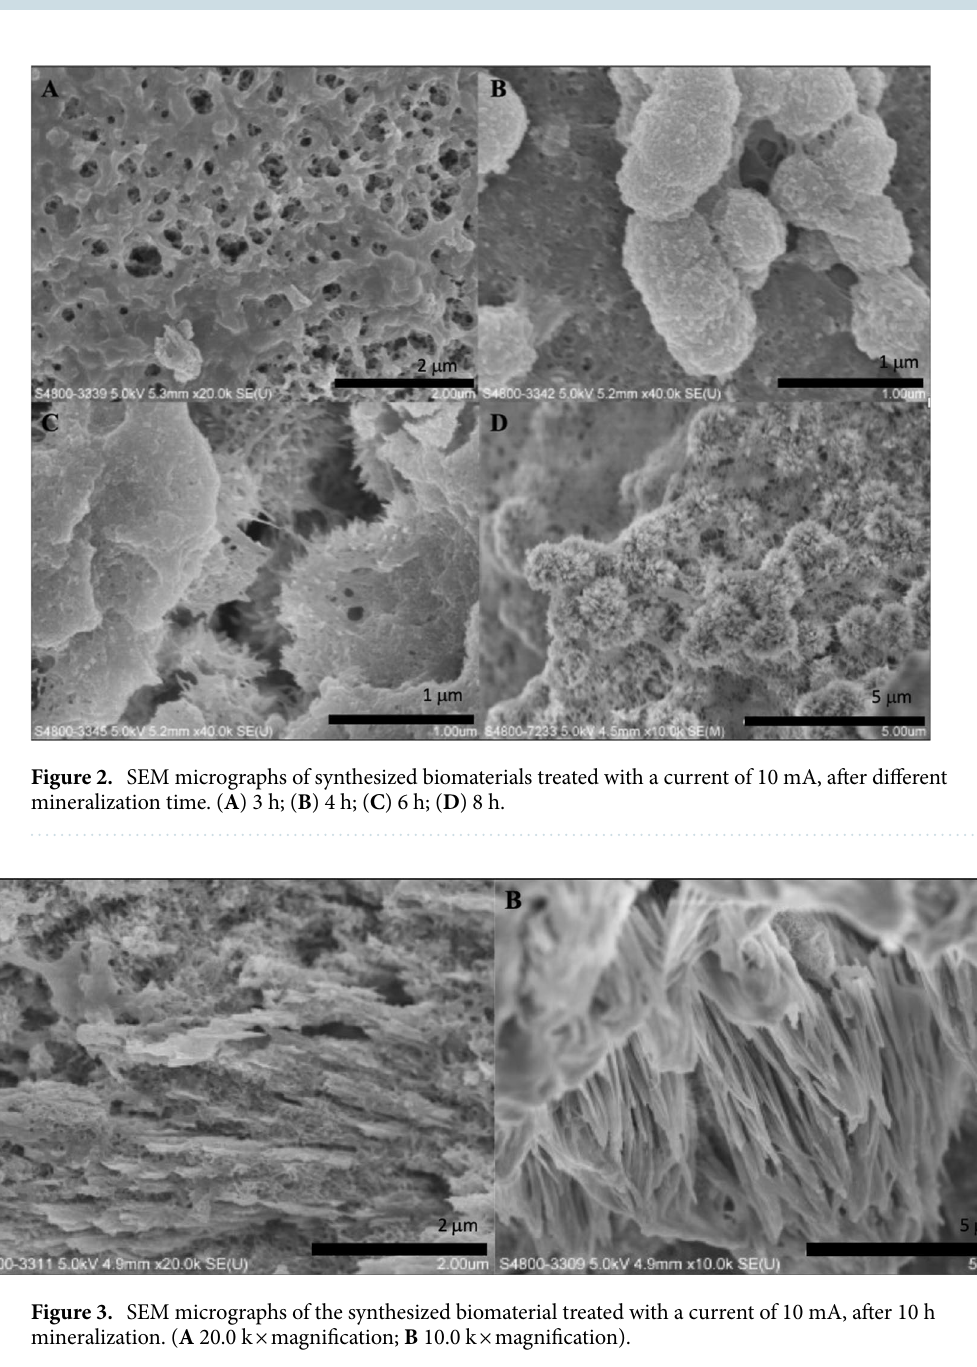
(Fig. 1C) and flower-like crystals (Fig. 1D) were formed, respectively. Figure 2 showed the surface of the syn- thesized biomaterials treated with different duration of mineralization. When the synthesized biomaterial was mineralized for less than 5 h, organic substance was the primary component formed. The SEM showed that formed crystals were wrapped with a layer of gelatine. When the mineralization time increased, more crystals were formed and the synthesized biomaterials became harder. After 8 h of mineralization, needle-like crystals were observed on the synthesized biomaterials (Fig. 2D). With increasing mineralization time, more crystals were formed. The crystal growth might be inhibited when HA crystals came into contact with one another, and finally, the crystals grew parallel to one another (Fig. 3). X-Ray Diffraction is a method based on the constructive interference of monochromatic X-rays and crystal samples. In this study, the XRD analysis was performed on the samples treated with 10 mA/10 h electrophoresis with addition of GO (Fig. 4). The XRD spectrum showed orientation of formed crystal bunches with the crystal plane (001) at 2θ = 9.3° of GO and (200) at 2θ = 22.1° of hydroxyapatite. Energy dispersive spectroscopy (EDS) was applied to measure the Ca/P ratio of the synthesized materials (Fig. 5). The EDS data showed that after 8 h of mineralization, the mean Ca/P ratio of synthesized materials was 1.68 ± 0.045.